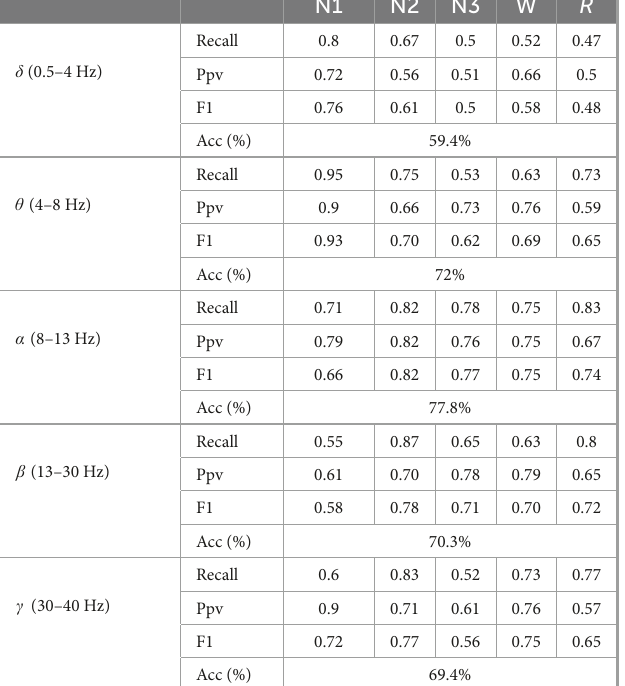
TABLE 4 Accuracy of classification of sleep stages by five frequency bands and five sub-periods under the sub-period feature fusion method. δ (0.5–